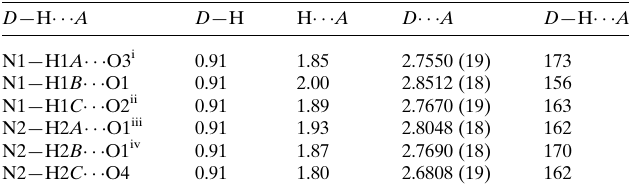
Table 1 Selected geometric parameters (A˚ , (cid:5) ). Mo—O1